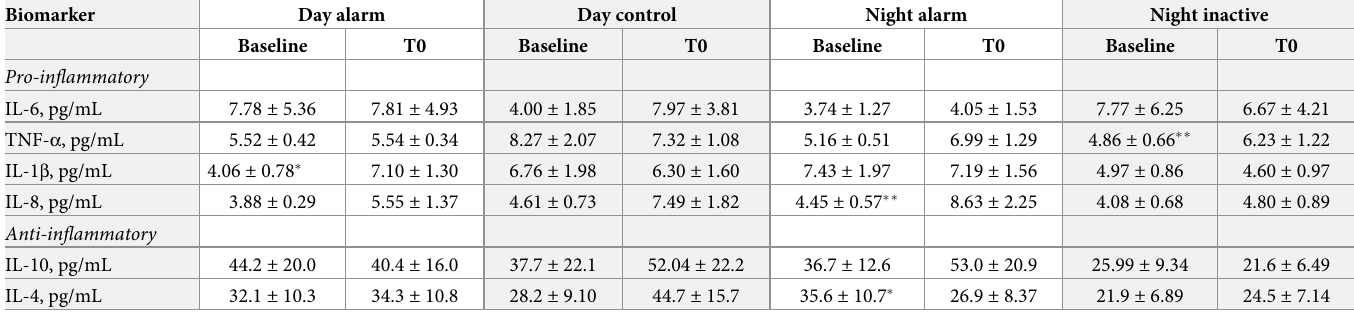
Table 1. Mean inflammatory marker values at 1400 h (baseline) and time of alarm onset (T0) for each condition. Biomarker